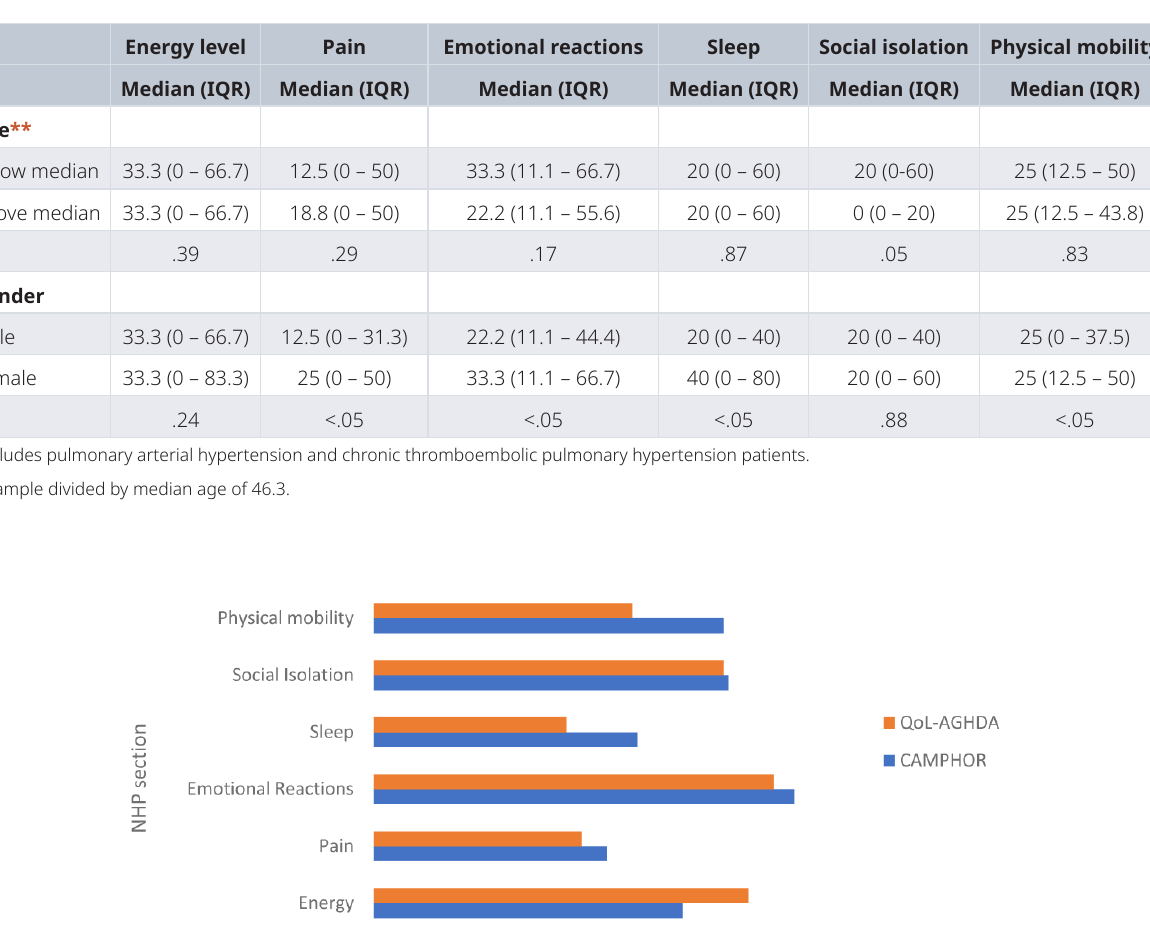
Table 7. Median NHP section scores by age and gender in combined sample of adult growth hormone deficiency and pulmonary hypertension* patients.